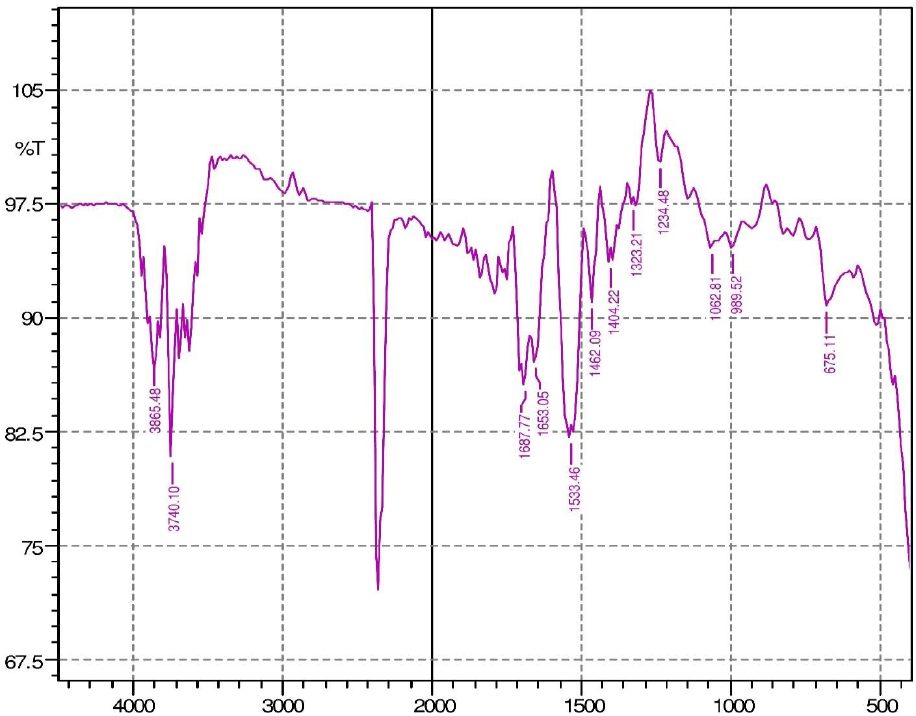
Figure 3. FTIR spectra of Bougainvillea spectabilis Willd. bracts.